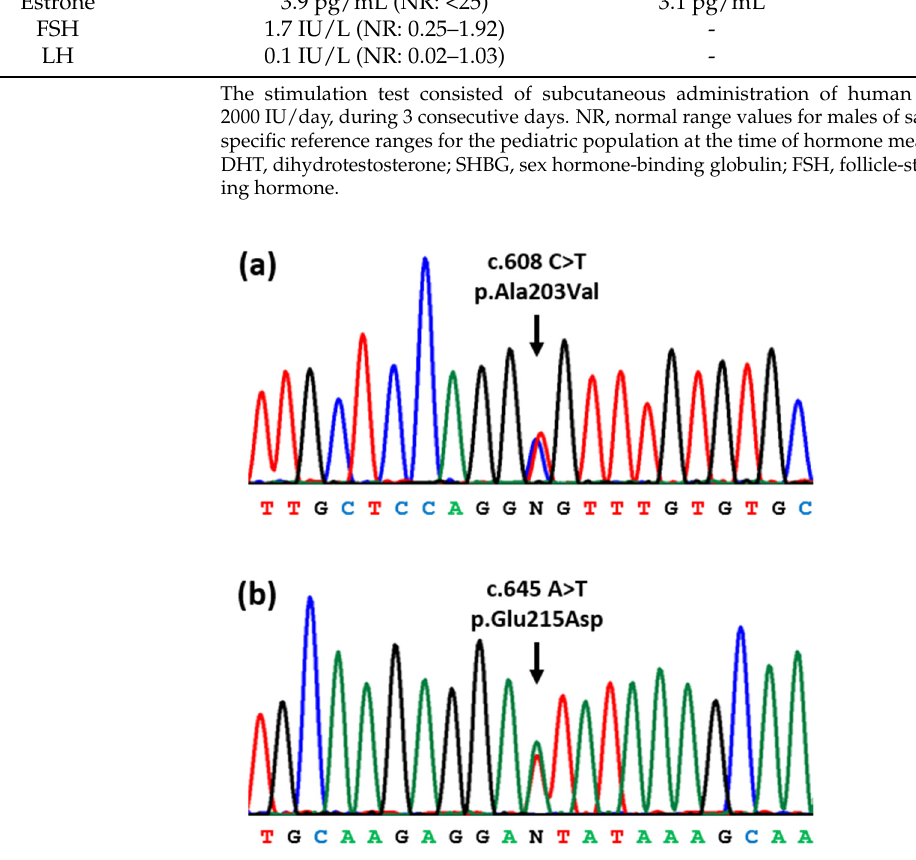
Figure 1. Partial DNA sequence of the 17-beta-hydroxysteroid dehydrogenase 3 ( HSD17B3 ) gene. The patient was found to be compound heterozygous for two missense mutations (arrows) in exon 9: ( a ) NM_000197.2:c.608C>T, p.Ala203Val; ( b ) NM_000197.2:c.645A>T, p.Glu215Asp.